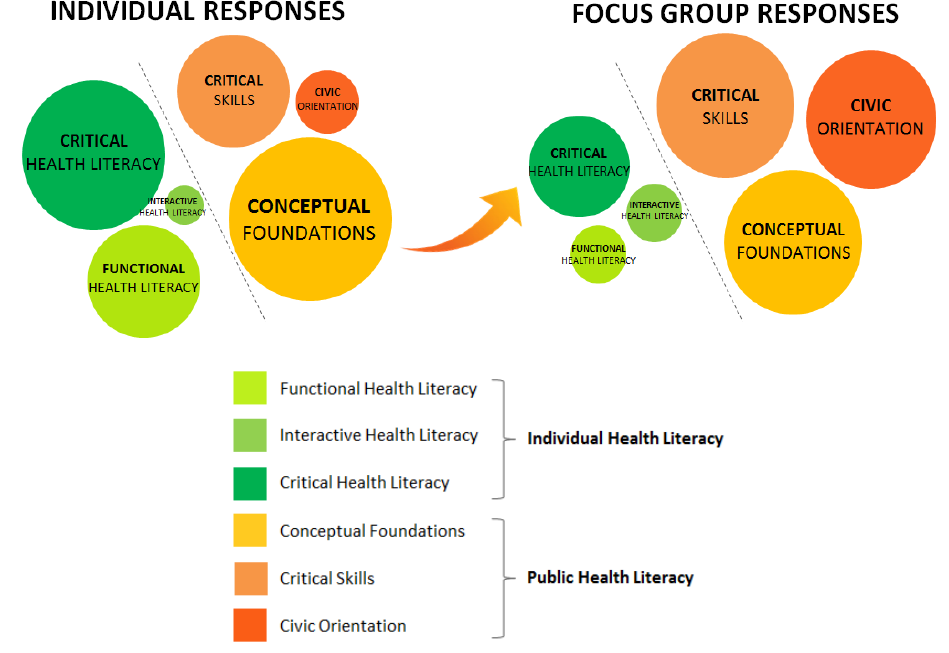
Figure 1. Distribution of Participant Responses in Individual vs. Focus Group Settings.